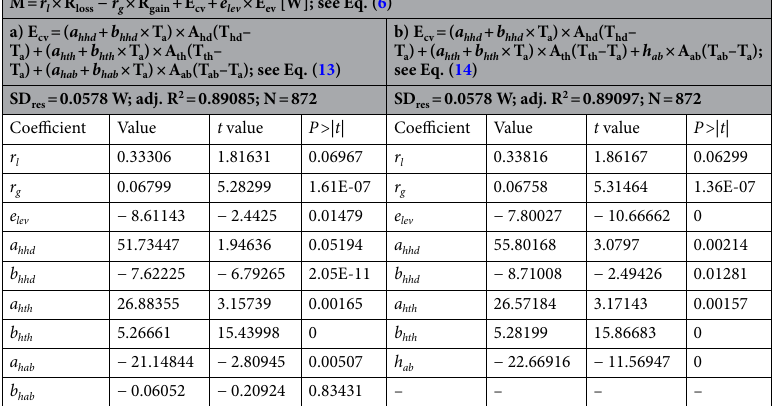
M = r l × R loss − r g × R gain + E cv + e lev × E ev [W]; see Eq. (6)